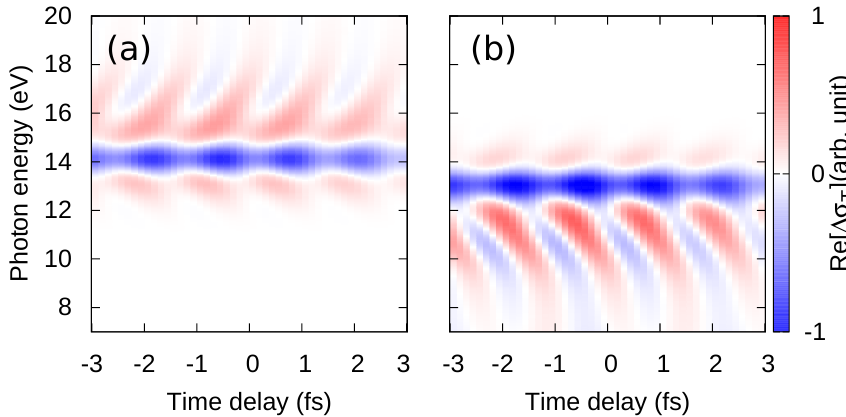
Figure 4. Transient surface conductivities of parabolic two-band models under the femtosecond IR pulse. The panels ( a ) and ( b ) show the result of the parabolic band shown as the blue-dashed line in Figure 3a, b,